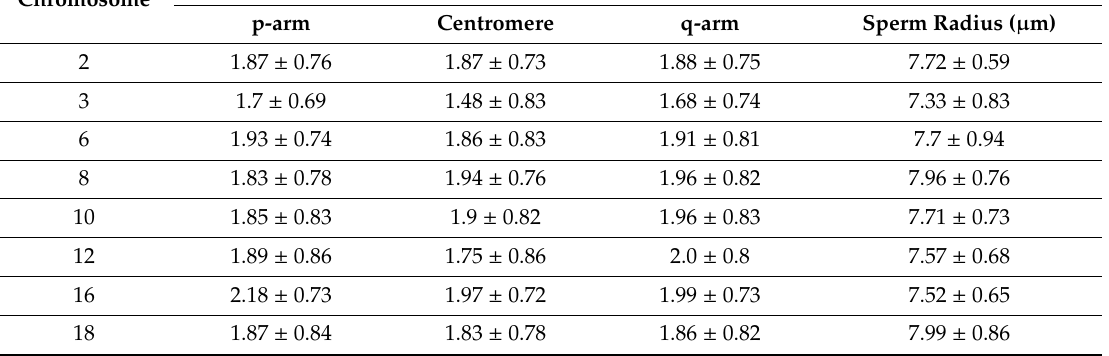
Table 1. Mean micrometer distance of the geometric center of target loci to the nearest nuclear edge in five subjects for eight di ff erent